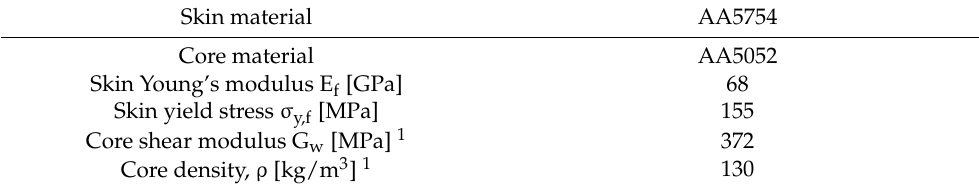
Table 1. Features of materials composing tested AHS.